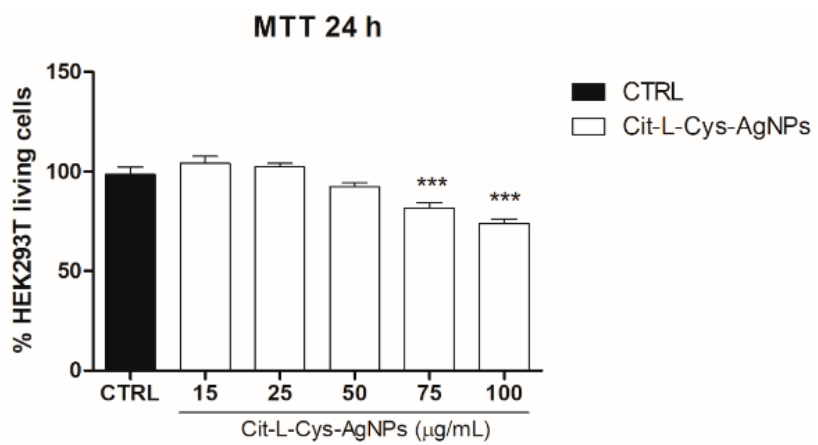
Figure 9. Effect of AgNPs/L-cys/citr on the viability of HEK293T cells. MTT assay was performed on cells treated with cit-L-cys-AgNPs (15-25-50-75-100 µ g/mL). *** p < 0.001 vs. CTRL